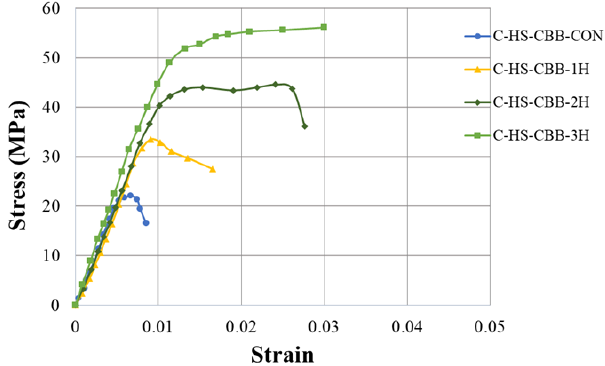
Figure 7. Stress – strain response of Type-1 concrete with and without hemp ropes confinement.